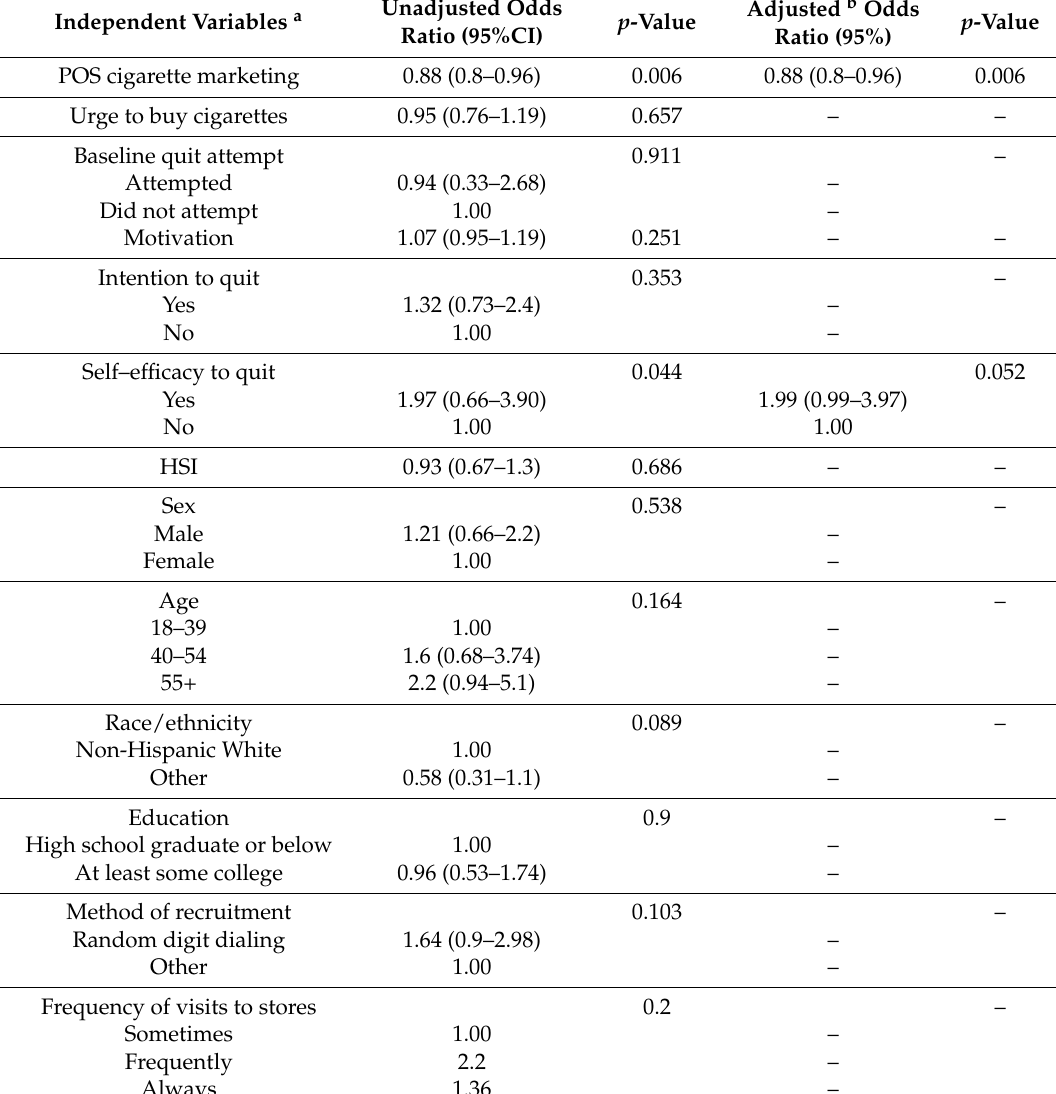
Table 3. Logistic regression results for the effect of exposure to point-of-sale (POS) cigarette marketing and other independent variables on the odds of quit success ( n =